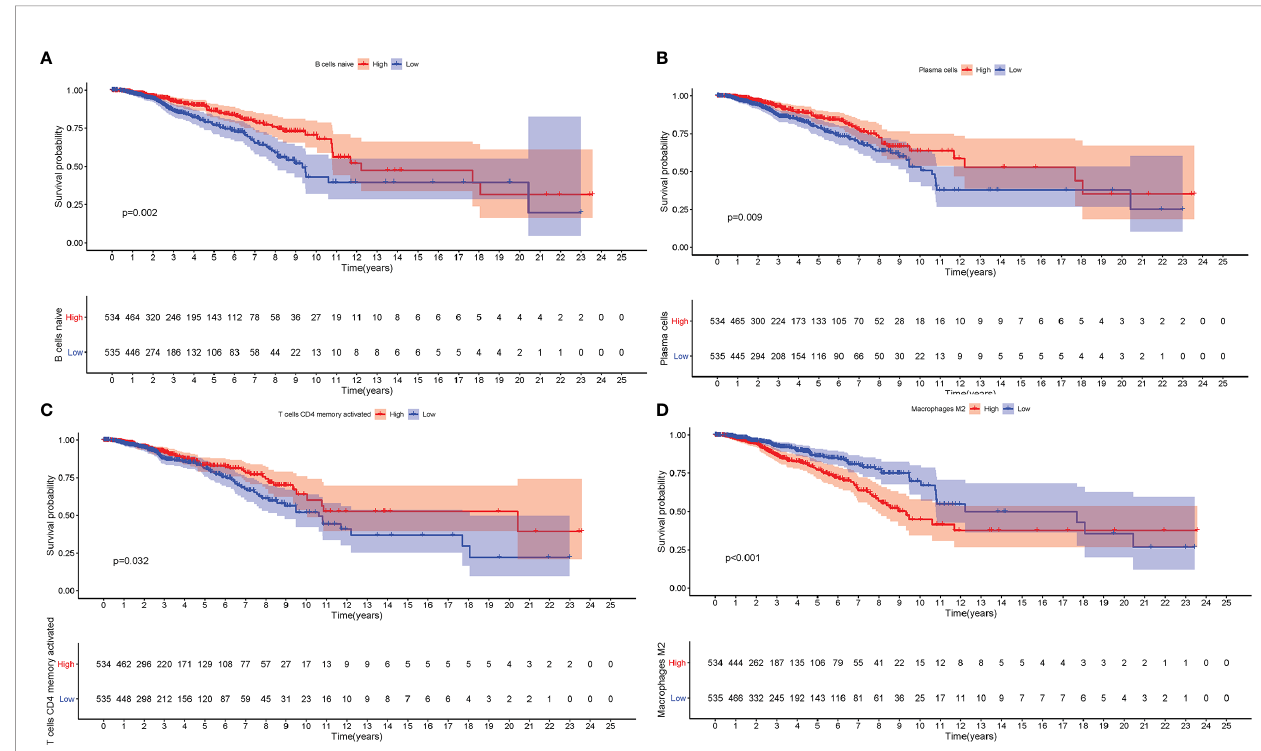
FIGURE 2 | The Role of Immune Cell In fi ltration in Prognosis. The overall survival analysis between patients with different in fi ltration levels of Naïve B cells (A) , Plasma cells (B) , activated memory CD4 T cells (C) , and M2 Macrophages (D)